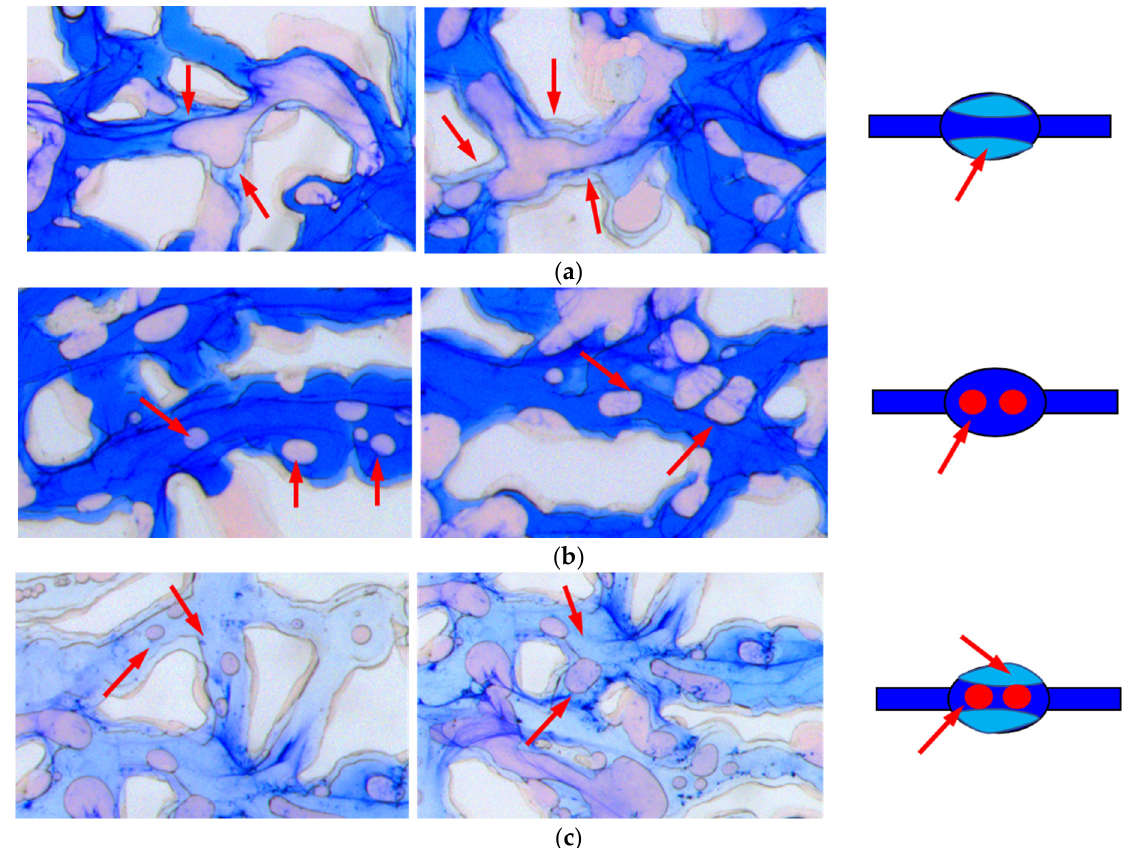
Figure 16. Microscopic image of gel-emulsifier composite water shutoff and analysis of water shutoff mechanism. ( a ) After the gel is injected, the main channel of the gel system stays on the rock wall, causing the oil–water circulation channel to narrow to block the water channel. ( b ) After the emulsifier is injected, the formed emulsion mainly stays in the center of the pore to realize the blocking of the water channel. ( c ) Under the synergistic effect of the gel and the emulsifier, the gel system stays at the edge of the pore body, and the emulsion stays in the center of the pore body.